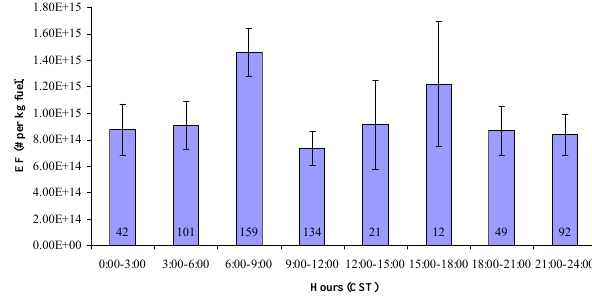
Figure 8. Average emission factor versus time of day. The numbers on the graph Fig. 8. Average emission factor versus time of day. The numbers represent the total number of CO 2 peaks that went into the calculation of the emission